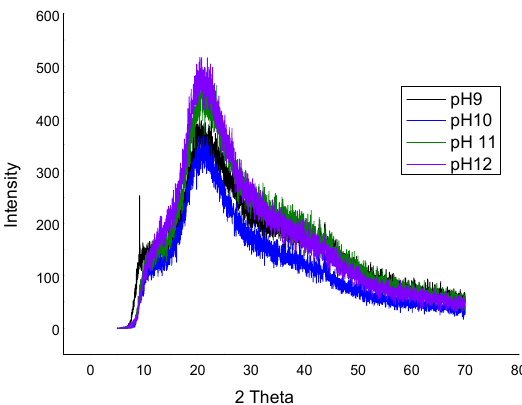
Figure 2. X-Ray Diffraction of FPC edible film made at pH 9, pH 10, pH 11, and pH 12.